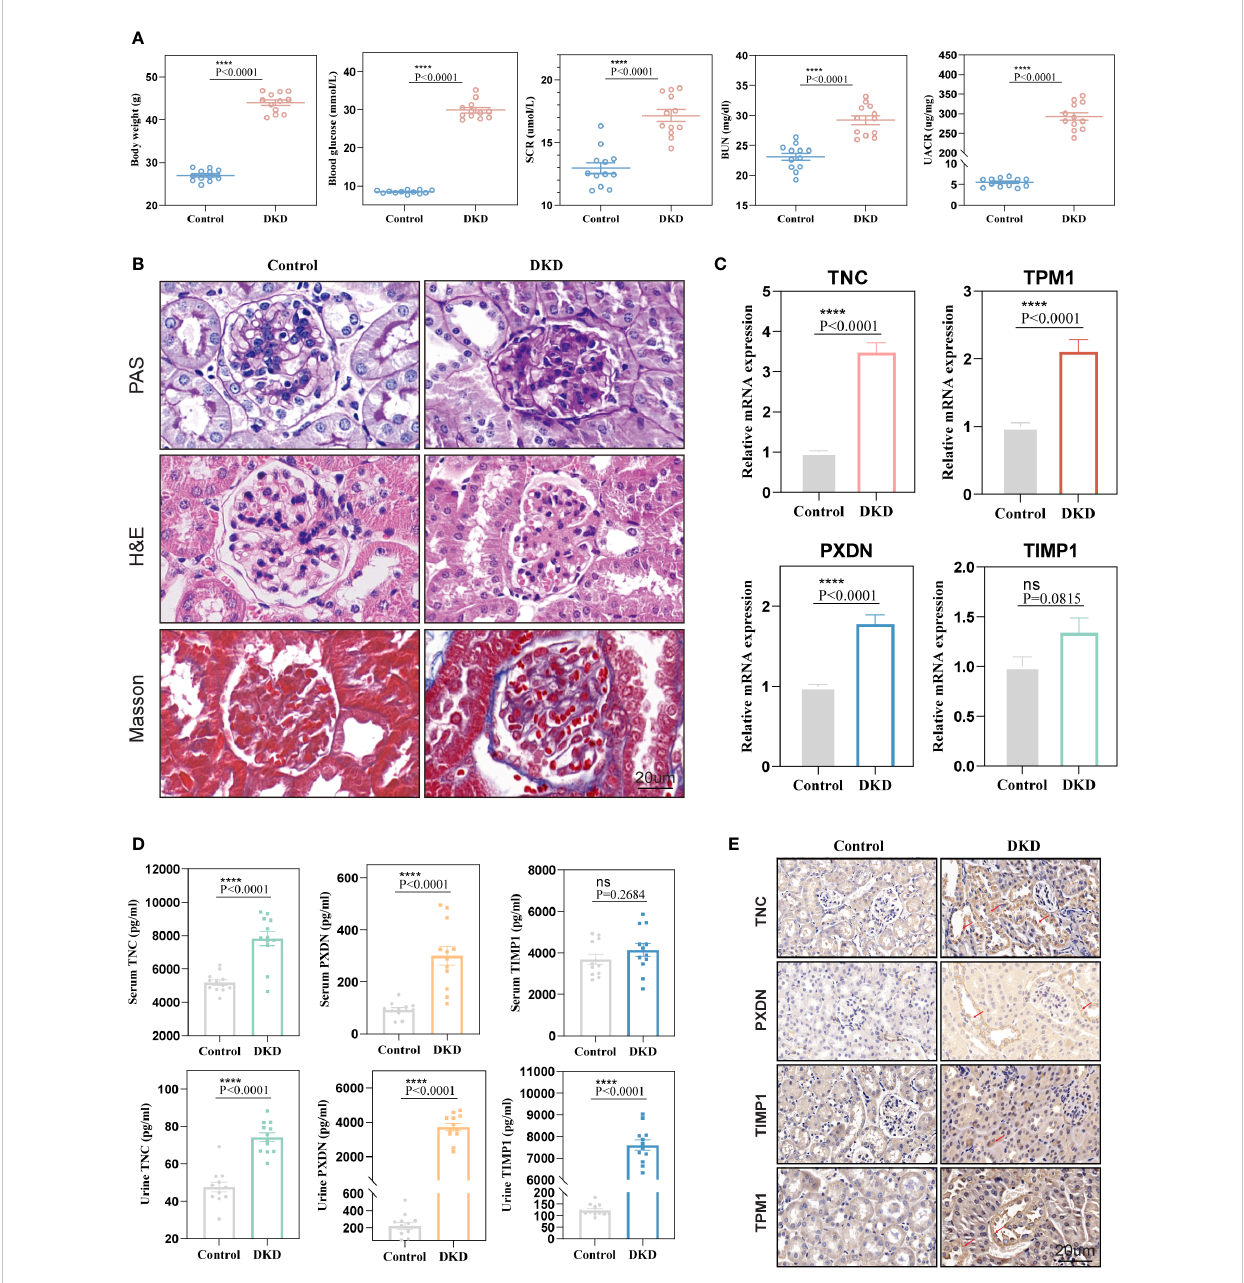
FIGURE 8 Validation of diagnostic markers in animal experiments. (A) The levels of body weight, blood glucose, serum creatinine, blood urea nitrogen, and urine albumin-creatinine ratio in mice. (B) Hematoxylin and eosin (H&E), periodic acid Schiff (PAS), Masson staining of mouse kidney. (C) mRNA expression levels of four diagnostic markers in kidney tissue. (D) Expression levels of markers in blood and urine. (E) Representative immunohistochemical staining of the kidneys for the four markers. ns, P <